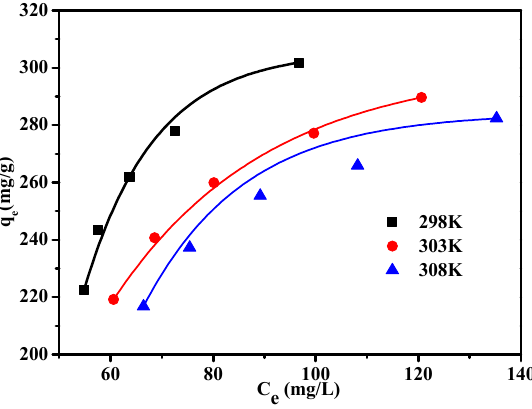
Figure 12. Adsorption isotherms of MSA-AC2 at three temperatures. Table 3. Isotherm constants for the adsorption of MB on MSA-AC2. T (K)